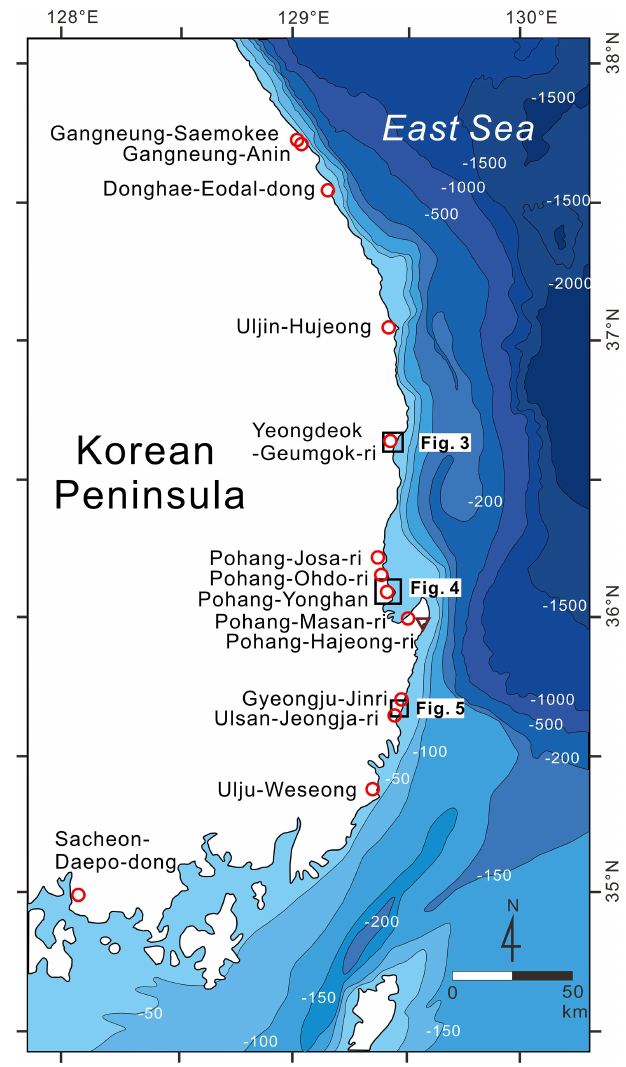
Figure 2. Map of the eastern and southern Korean Peninsula show- ing detailed bathymetry and marine terraces locations. Red cir- cles represent sea-level indicator locations based on OSL ages with exception of the Pohang-Masan-ri area, which has an additional paleomagnetic-based age. An inverted triangle shows the location of a terrestrial limiting point. Age data can be found in Table 3. Bathymetric contour interval is in